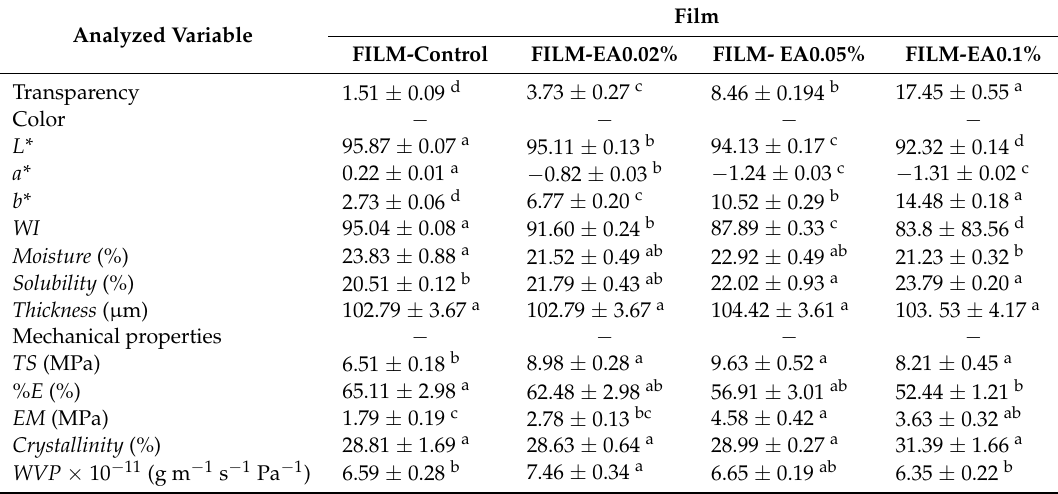
Values represent the average of three repetitions ± standard error; Different letters in each row are significantly different ( p < 0.05); DAFB, days after full bloom; WI , whiteness index; TS : tensile strength; % E : elongation at break; EM : elasticity modulus; WVP: water vapor